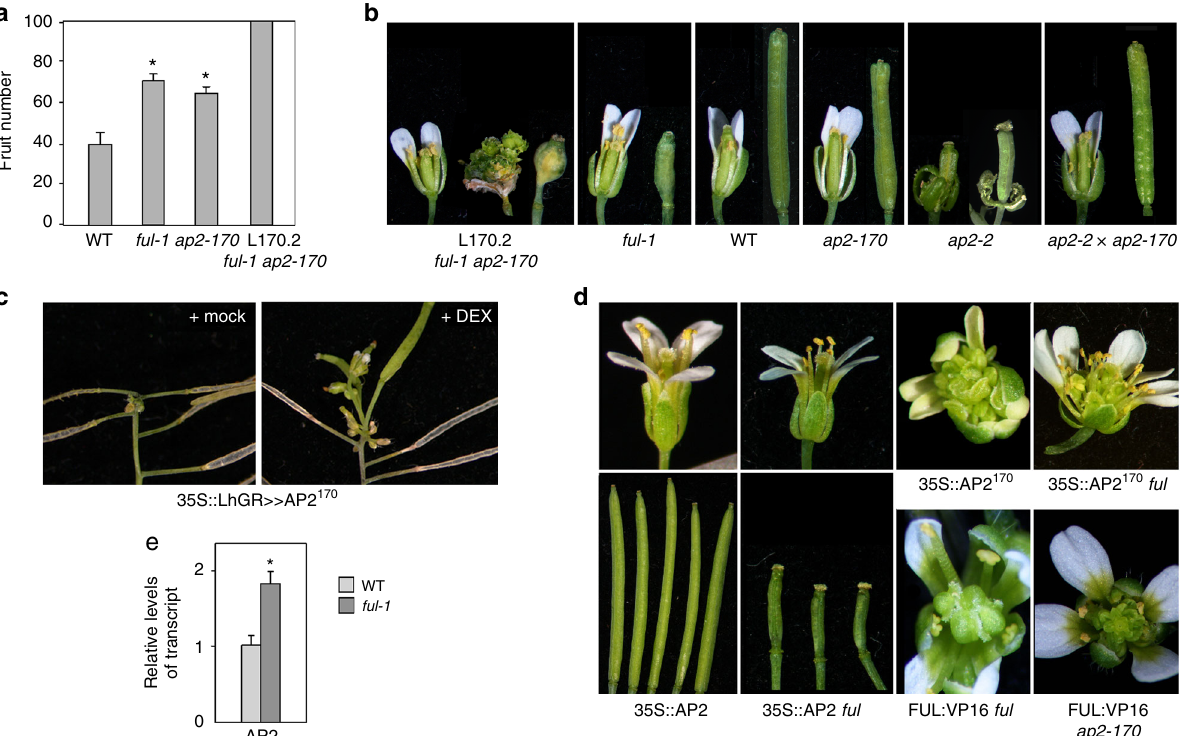
Fig. 3 FUL controls GPA timing by regulating AP2 activity in the SAM. a L170.2, a mutant from a second-site mutagenesis on ful-1 , shows a dramatically delayed GPA, with plants producing more than 100 fruits and usually dying of other causes before GPA can take place; L170.2 carries a mutation in the miR172 binding site of AP2 (renamed as ap2-170 ). When segregated from the ful-1 background, the ap2-170 mutation also delays GPA. n = 10 for all genotypes. b L170.2 bears highly indeterminate fruits, but not ful-1 or ap2-170 single mutants; ap2-170 mutants or heterozygous ap2-170/ap2-2 plants do not show the typical homeotic defects of ap2-2 mutants. c Induction of AP2 170 expression in arrested plants reactivates SAM and fl ower and